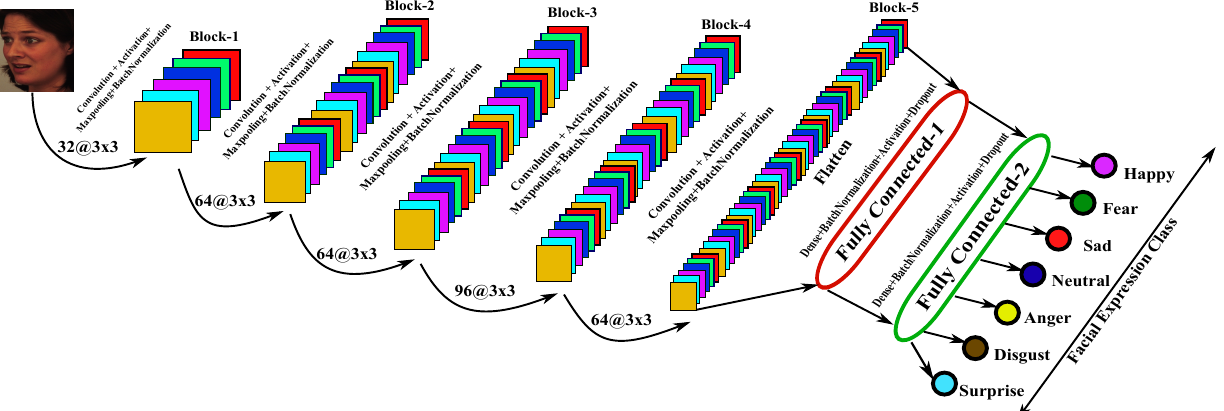
Figure 4. CNN 1 architecture for the proposed FER system, that takes the input image F of size ( n 1 × n 1 × 3 ) .